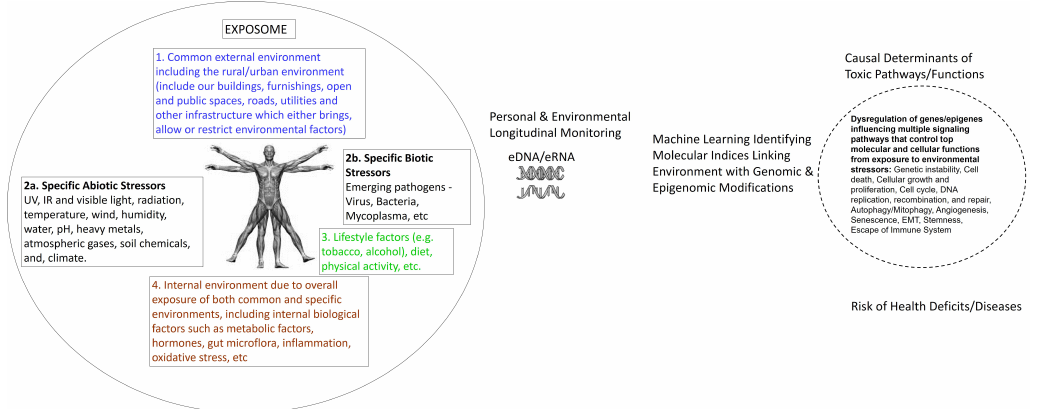
Figure 3. From the exposome-to-molecular toxicogenomics basis of assessing risk of environment related health